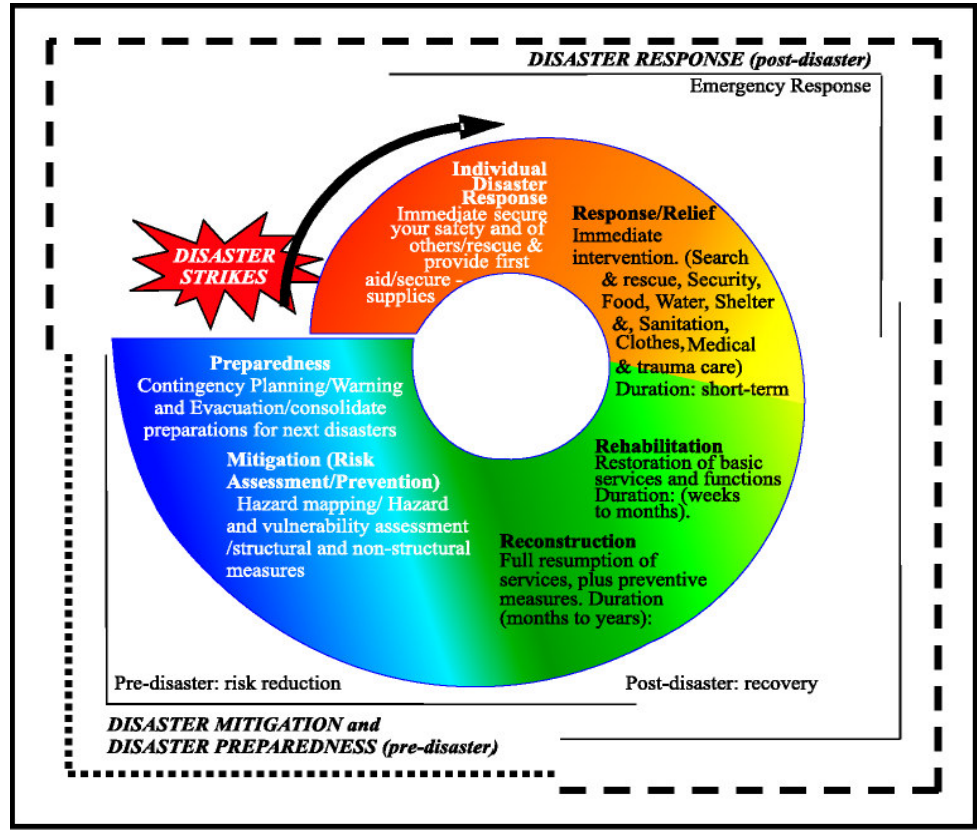
Figure 2. Disaster